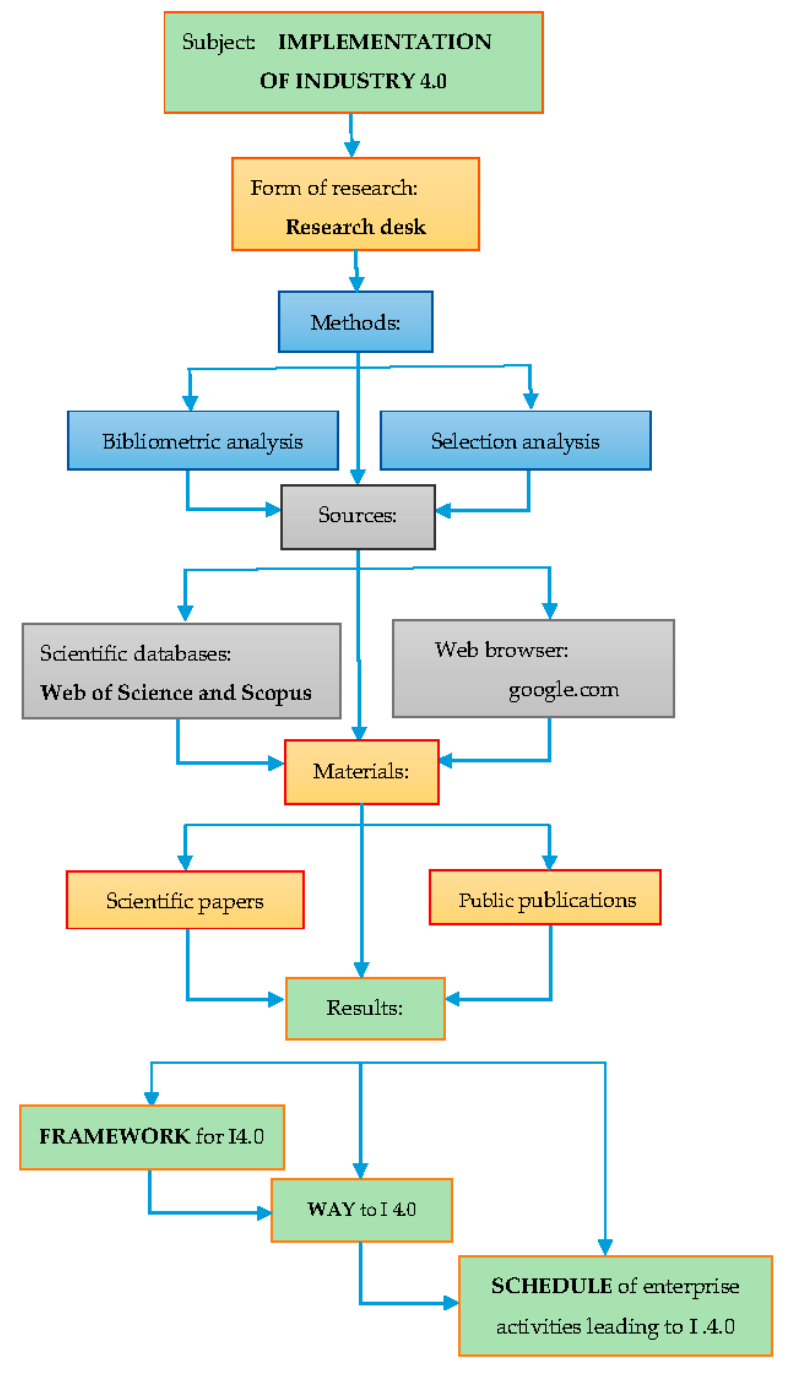
Figure 1. Diagram of the research being carried out. Source: Own study.